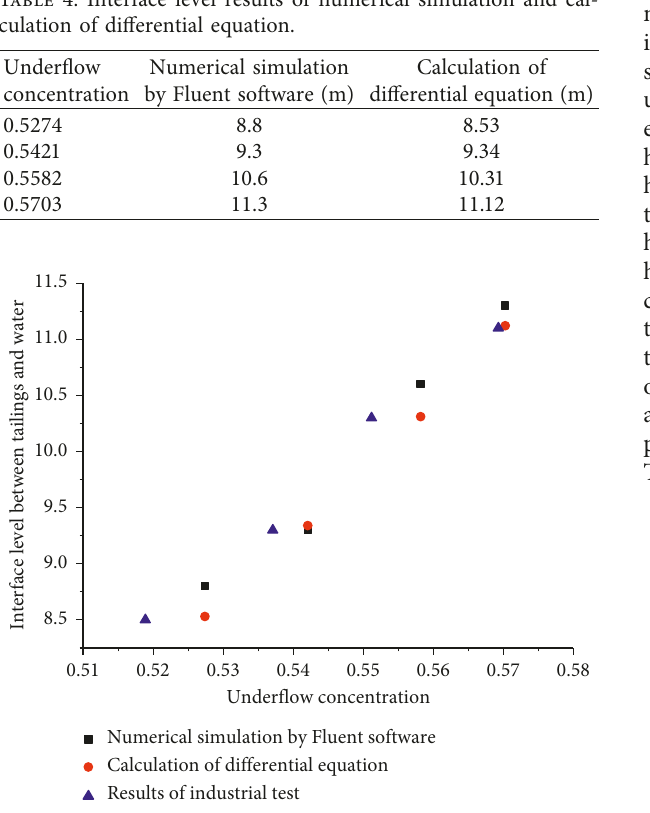
Figure 8: Relationship of underflow volume concentration and interface levels between tailings and water via numerical simulation by Fluent software, calculation of differential equation, and in- dustrial test.